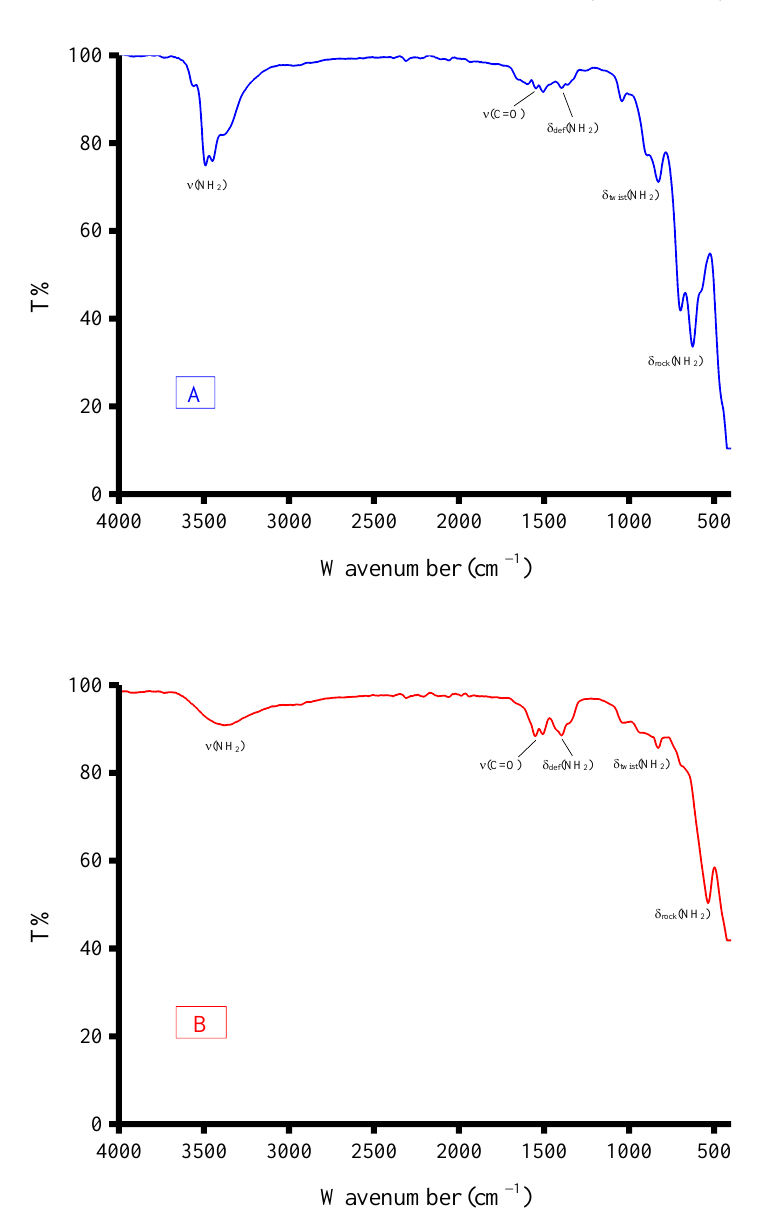
Figure 1. IR spectra of solid mixtures: ( A ) (Zn(NH 2 CONH 2 ) 6 )Cl 2 and (Fe(NH 2 CONH 2 ) 6 )Cl 3 ; ( B ) (Zn(NH 2 CONH 2 ) 6 )(CH 3 COO) 2 and (Fe(NH 2 CONH 2 ) 6 )Cl 3 .